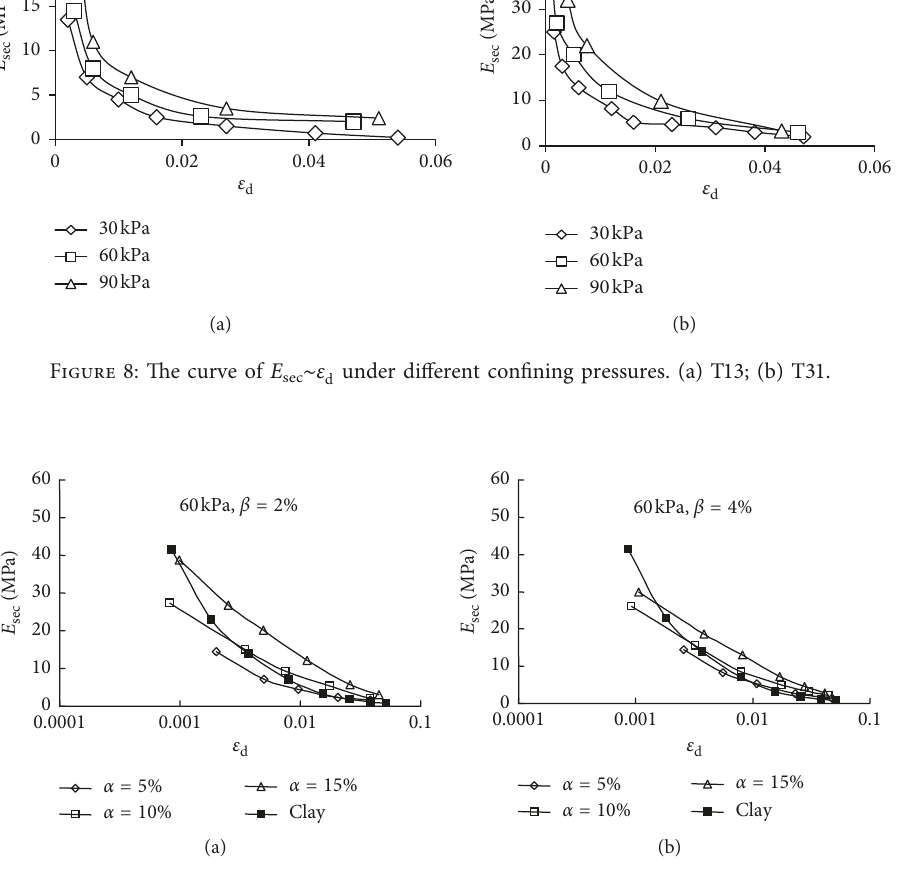
∼ ε sec d on different cement content.